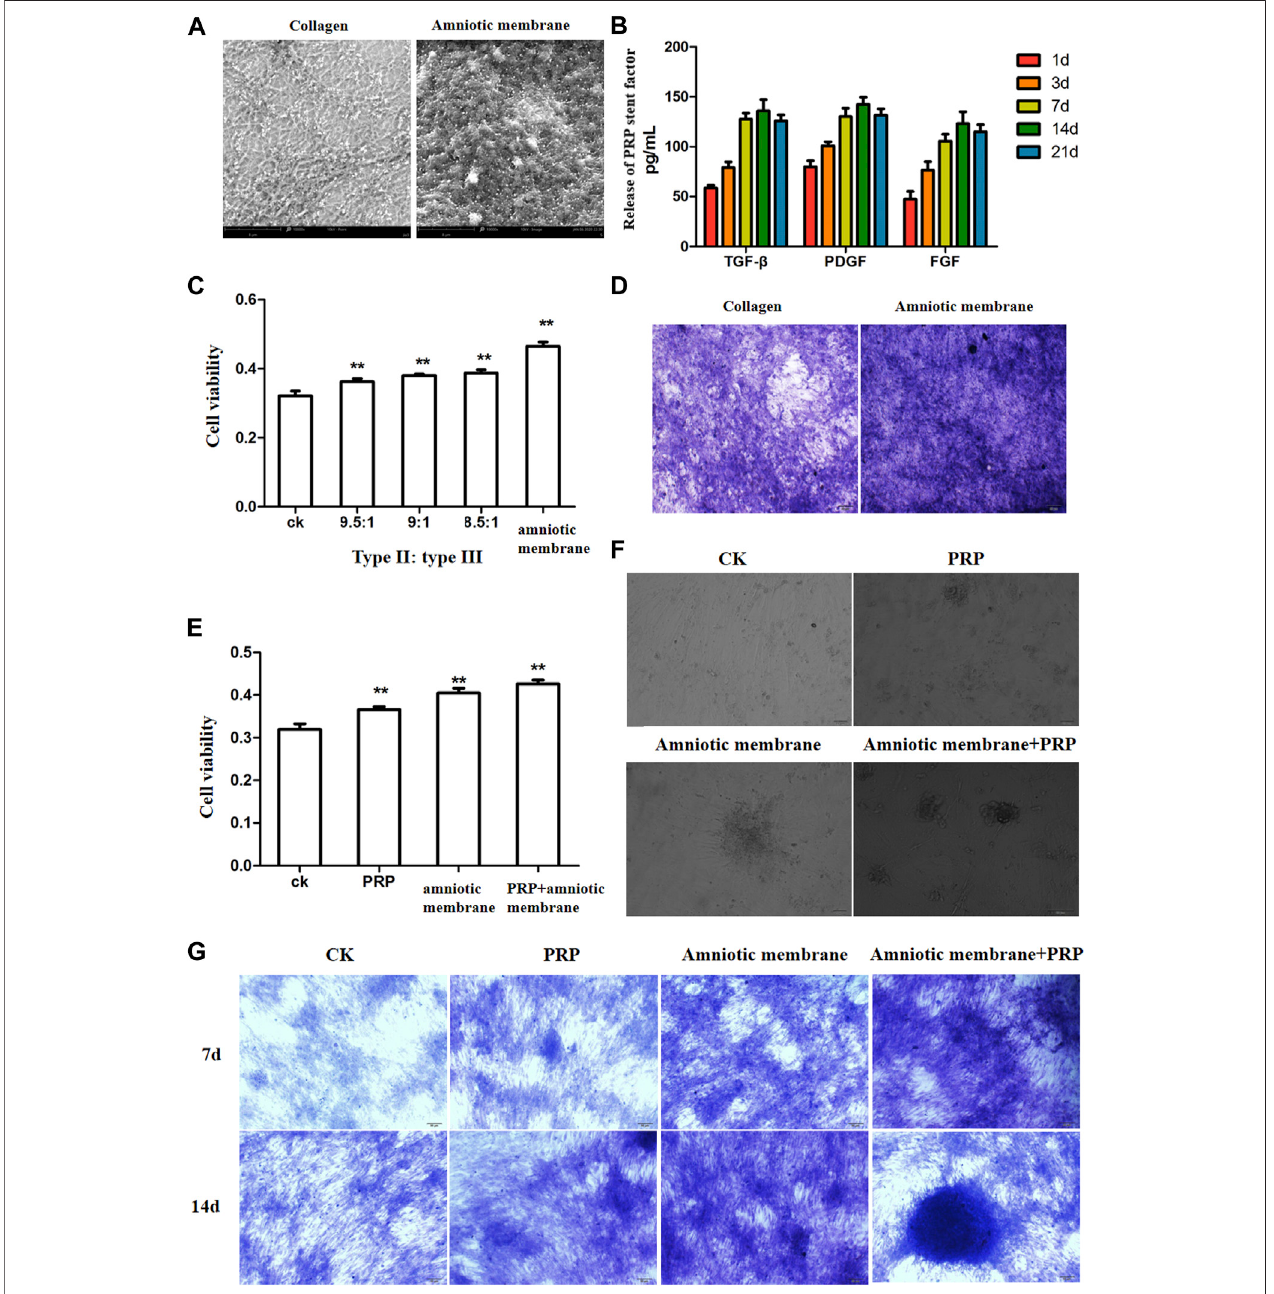
FIGURE 2 | The combination of amniotic membrane and PRP scaffolds showed the best effect for stem cell transplantation, growth, and differentiation. (A) Comparison between collagen scaffolds and amniotic membrane scaffolds under a scanning electron microscope. The surface of the amniotic membrane scaffolds is dense, n (cid:2) 3. (B) Thesecretions ofvarious factorsinPRPweredetected byELISAatdifferenttime points.TheresultsshowedthatthereleaseofTGF- β ,PDGF,andFGF increased with the extension of time, and the increase slowed down at the 14th day, and the decrease trend weakened at the 21st day, n (cid:2) 4. (C) CCK8 was used to detect the effect of different proportions of collagen and amniotic membrane scaffolds on ADSC proliferation. The amniotic group had the highest cell activity. **p < 0.01. Control: ADSC. n (cid:2) 3. (D) The toluidine blue staining assay showed that the effect of cell cartilage formation in the amniotic membrane scaffolds group was better thanthatincollagen, n (cid:2) 4. (E) CCK8assaywasusedtodetecttheproliferationofADSCsunderdifferenttreatments.TheADSCinthePRP+amnioticmembranegroup showed the fastest proliferation and the best vitality. CK: ADSC alone; PRP: PRP + ADSC; amniotic membrane: amniotic membrane + ADSC; PRP + amniotic membrane: ADSC + PRP + amniotic membrane. **p < 0.01. (F) The growth of ADSCs was observed through an optical microscope. The results showed that amniotic membrane + PRP scaffolds well promoted the clustered growth of ADSCs. , n (cid:2) 4. (G) The growth and differentiation of ADSCs were detected by toluidine blue staining at different time points. The cells in the amniotic membrane + PRP scaffolds group exhibited the best growth and differentiation. On the 14th day, chondrocytes were induced, n (cid:2) 3.